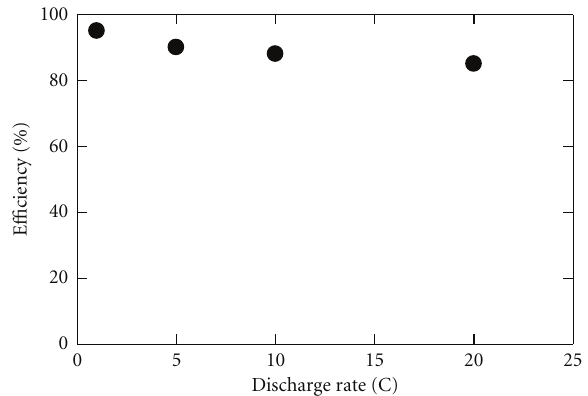
Figure 8: The change of a discharge capacity in alternately repeating rechargeable to 20 times at 1 C and